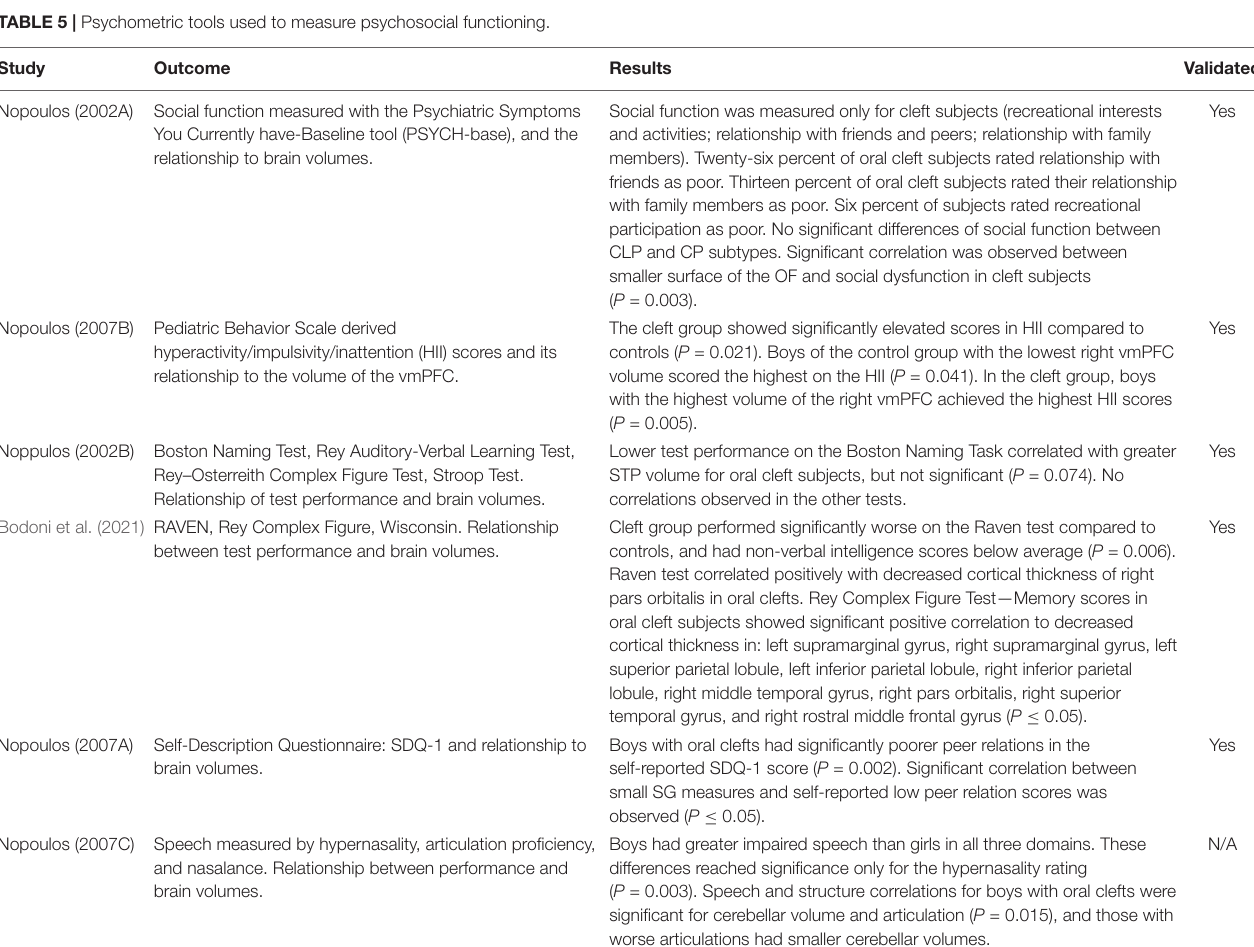
TABLE 5 | Psychometric tools used to measure psychosocial functioning.